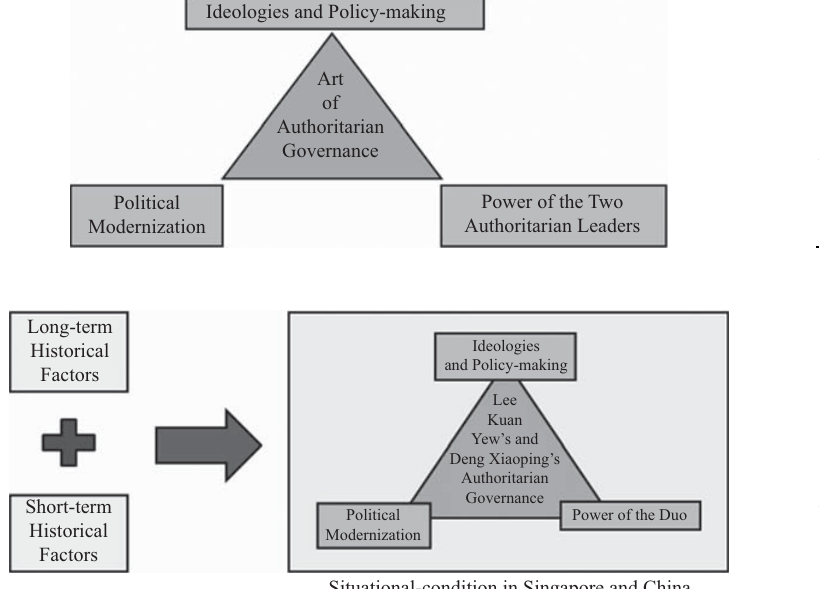
Figure 1. Interlocking